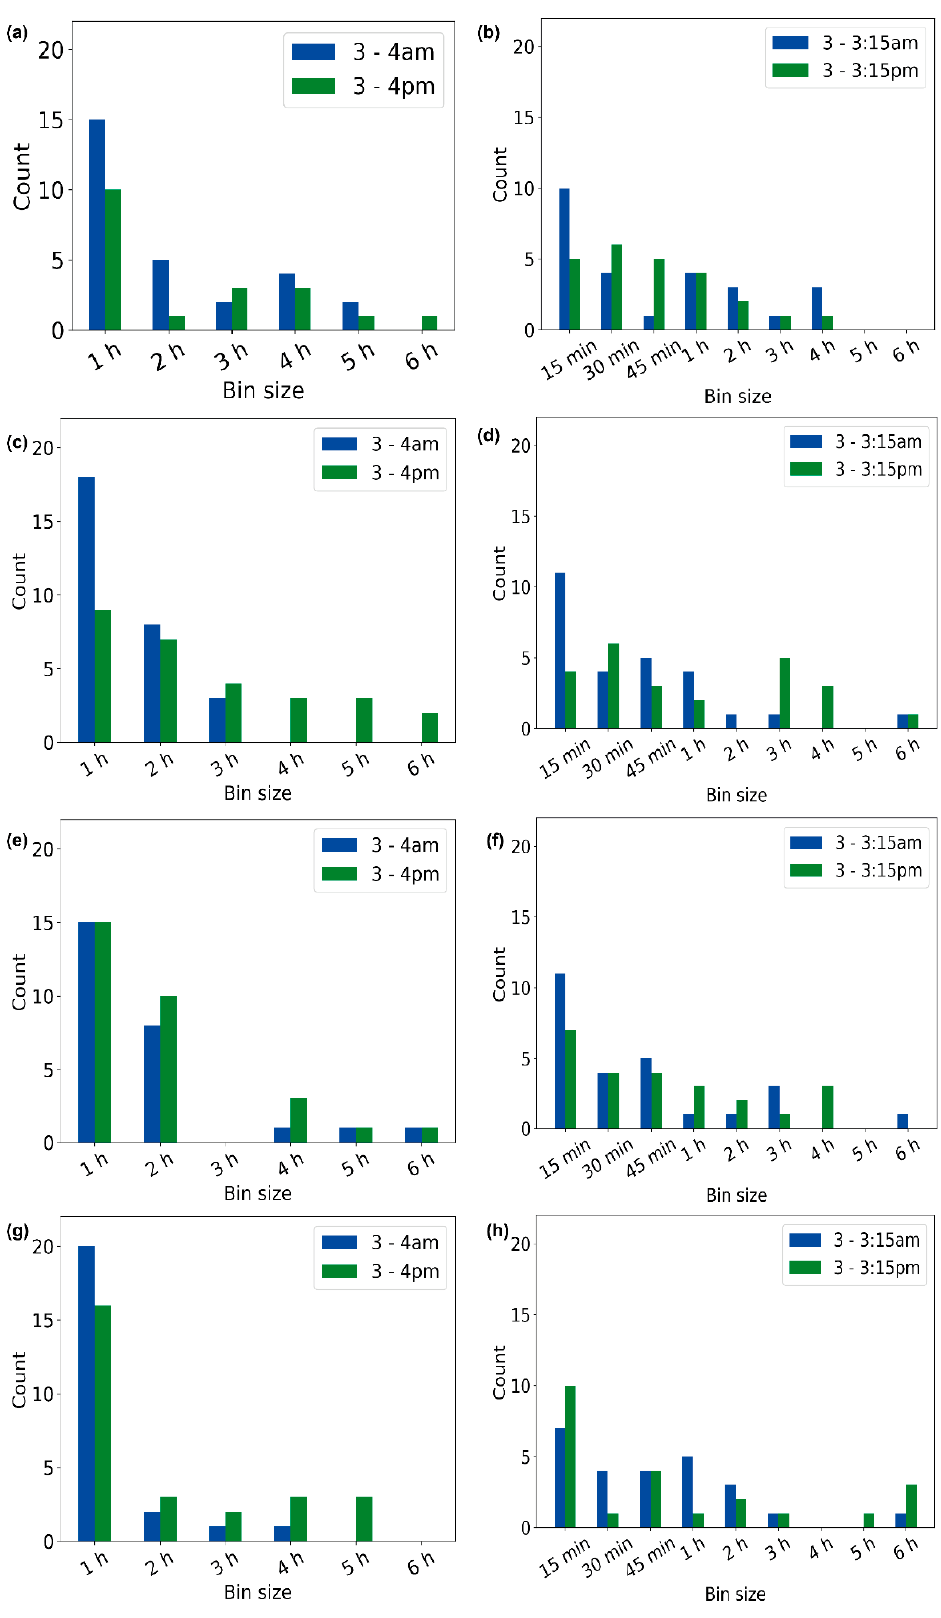
Figure 6. Dominance of the optimal bin size for active and inactive periods. For 1 h and 15 min of missing data for volunteers V1 ( a , b ), V2 ( c , d ), V3 ( e , f ), and V4 ( g , h ).